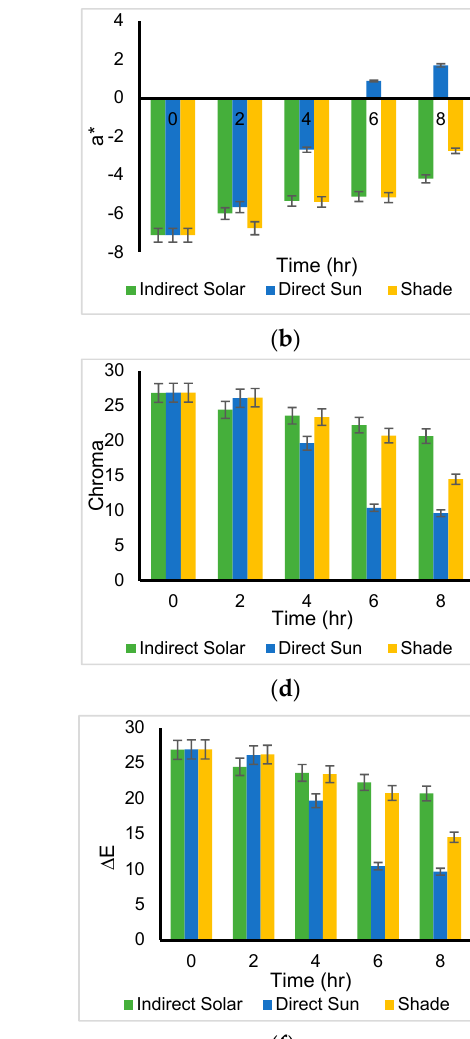
Figure 8. Basil DGCI degradation during different drying methods ( n = 3). The color parameter considered is an important factor that indicates the quality of the herbs. In this research, the indirect solar dryer shows good color retention capability in all selected herbs. Figure 9 presents visuals of mint color degradation during the drying process.